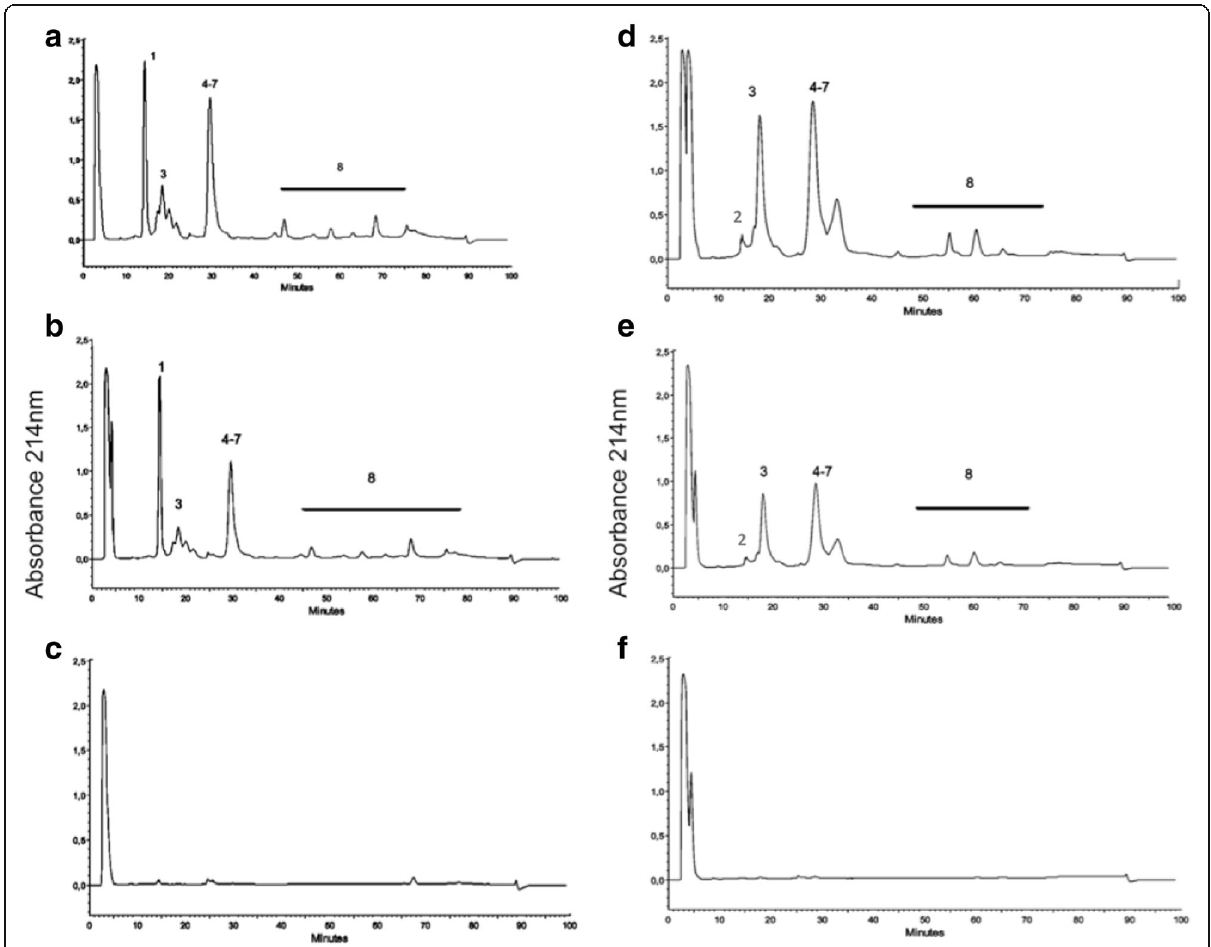
Fig. 3 Antivenomics analyses of crotalic antivenom manufactured by IVB from optimized venom mixture. a and d about 300 μ g of crotamine- positive and crotamine-negative venoms separated by RP-HPLC, respectively. b and e the RP-HPLC profiles of immunocaptured fractions of crotamine-positive and crotamine-negative venom from affinity column with crotalic antivenom SAC155204F (raised against a pool of both types of venoms), respectively. c and f the flow-through fraction of crotamine-positive and crotamine-negative venoms, respectively. The elution conditions were: isocratic gradient with 5% of 0.1% TFA in 100% of acetonitrile (solvent B) for 5 min, followed by 5-25% B for 5 min, 25 – 45% B for 60 min, 45 – 70% B for 10 min, with a final isocratic step of 70% B for 5 min at a flow rate of 1 mL/min. The first peak present in all chromatograms (elution time ~ 3 min) is a technical artifact. Protein families associated with HPLC peaks: 1 – crotamine, 2 – disintegrin, 3 – crotoxin acid chain 4 to 7 – crotoxin basic chain and 8 – fractions of low expression toxins including D49-PLA 2 , serine protease (gyroxin), C-type lectin (convulxin) and